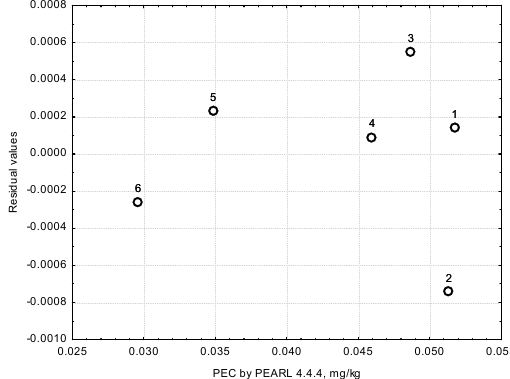
Figure 6. Dependence of error distribution on the PEARL 4.4.4 predicted value.